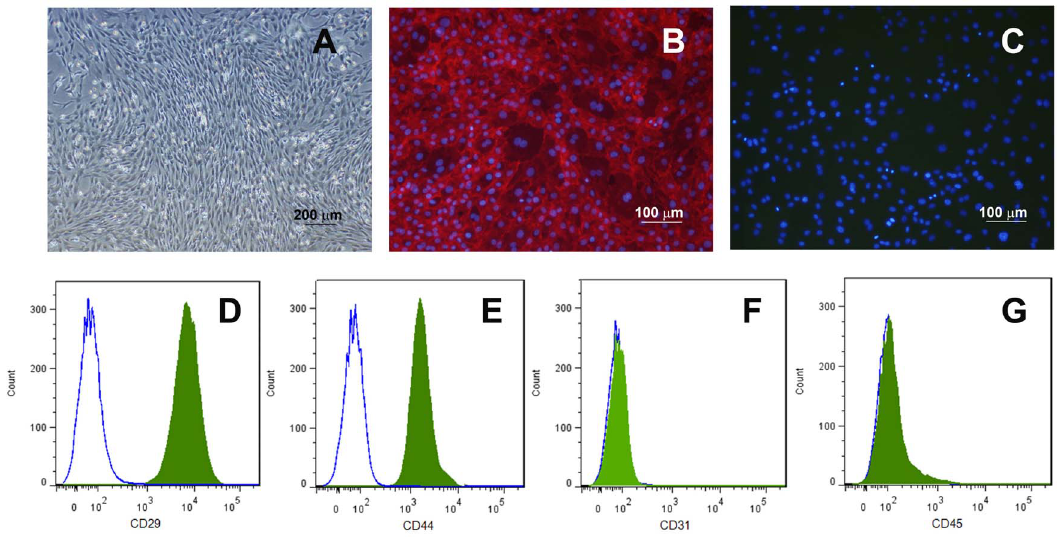
Figure 1. Immunophenotype of rat MSCs. Rat MSCs display spindle shape and reach confluent at 14 days post-isolation ( A ). More than 98% of the population are positive to the mesenchymal markers CD29 ( B, D ) and CD44 ( E ), and negative to the hematopoietic markers CD34 ( C, F ) and CD45 ( G ). Green shaded profile, antibodies staining; blue open profile, isotype control.